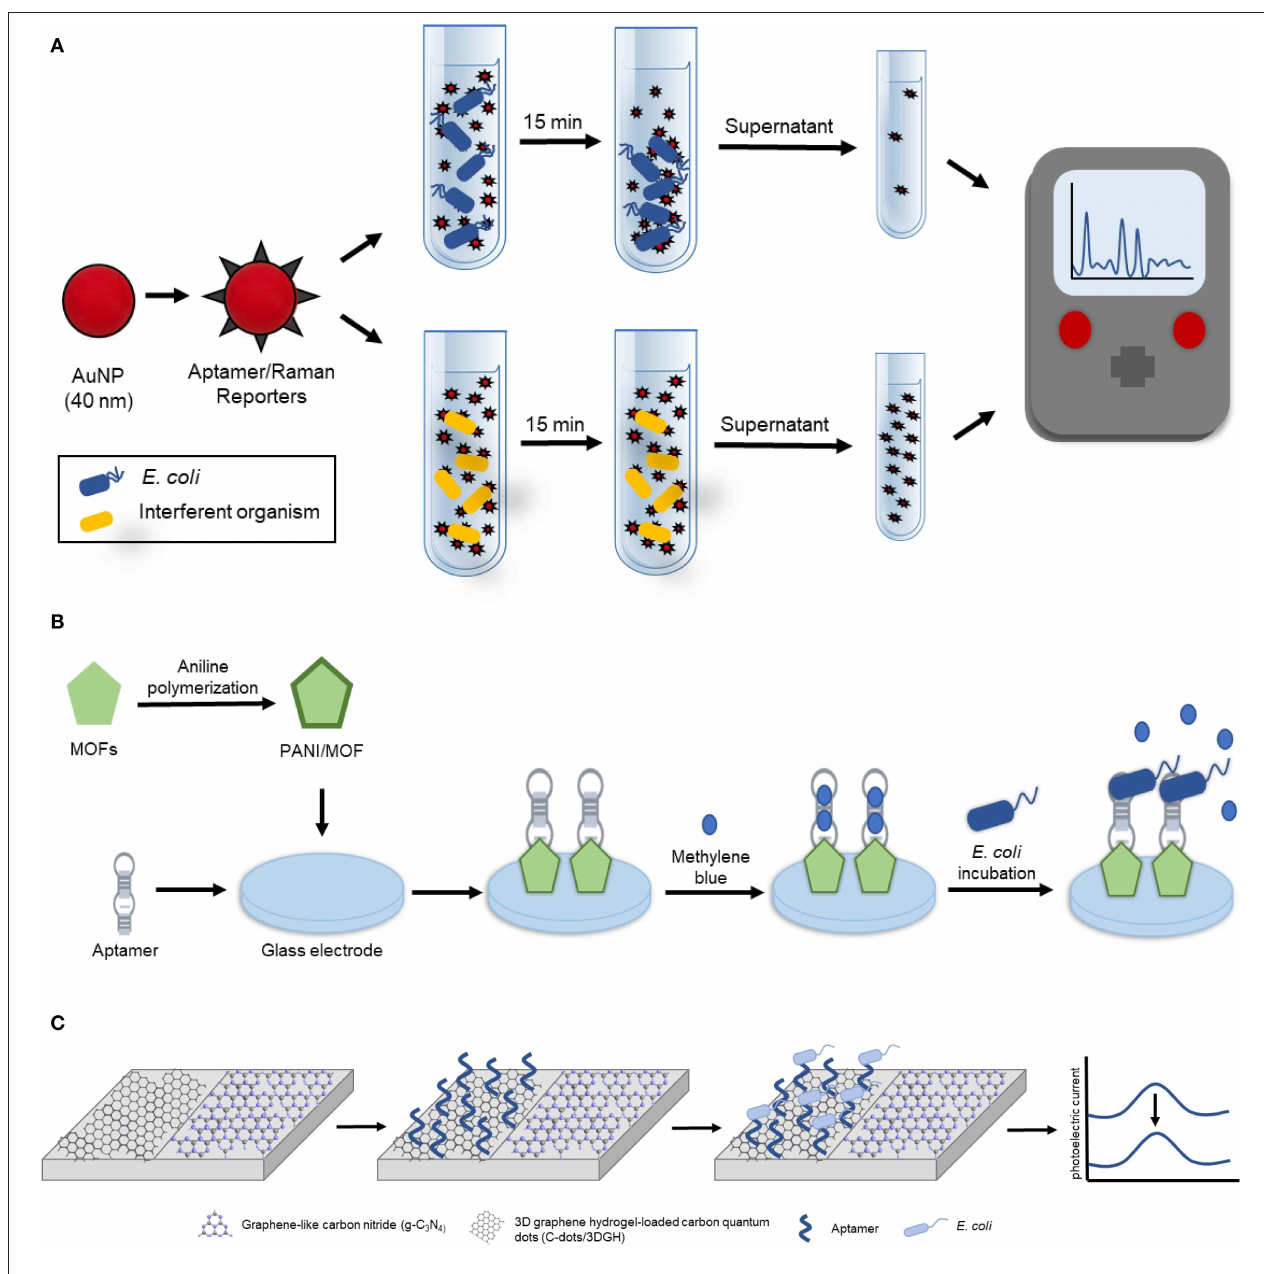
FIGURE 2 | Aptamer-based detection strategies for E. coli . (A) Schematic illustration of the aptamer-based SERS biosensor for whole cell detection of E. coli O157:H7 (Díaz-Amaya et al., 2019). (B) Schematic representation of electrochemical aptasensor fabrication based on amino-functionalized metal-organic frameworks and E. coli O157:H7 detection (Shahrokhian and Ranjbar, 2018). (C) Schematic diagram of the ratiometric photoelectrochemical aptasensor for the detection of E. coli (Hua et al., 2018).